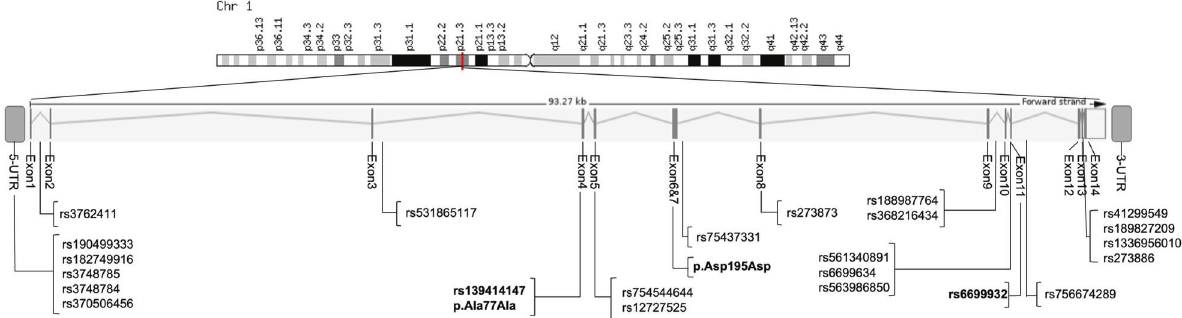
Fig. 1 Genomic structure of the PTBP2 gene (derived from Ensembl, GRCh38.p13) including the location of the 25 detected variants. Bold: Variants located in the coding